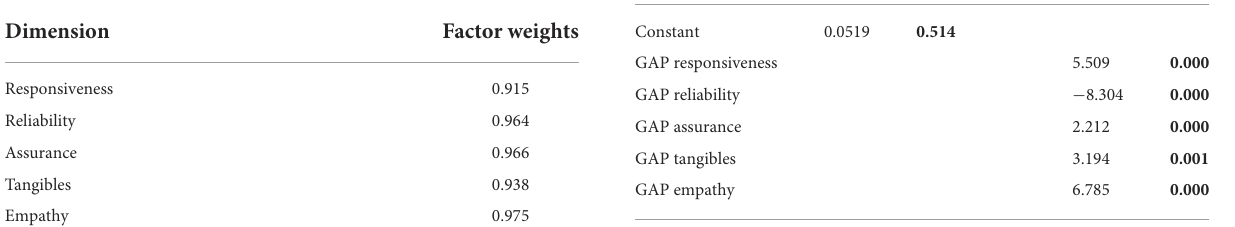
TABLE 8 Factor weights for each dimension after measuring the GAP.